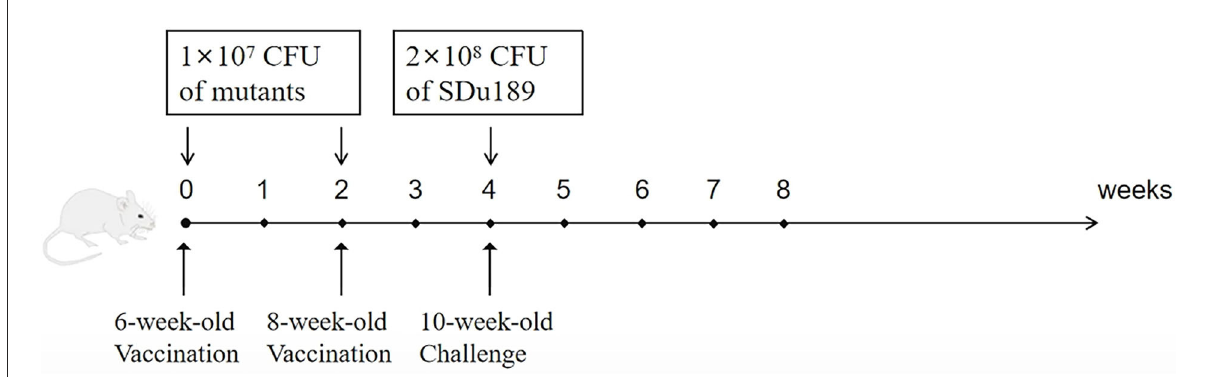
FIGURE5 BALB/c mouse immunization protocol and protective efficacy of Sdu189 1 spiC or Sdu189 1 spiC 1 aroA. Mice immunized with different doses of Sdu189 1 spiC , Sdu189 1 spiC 1 aroA, or PBS were intramuscularly challenged at 2 weeks post-immunization with virulent S . Dublin strain Sdu189, and mortality was recorded.